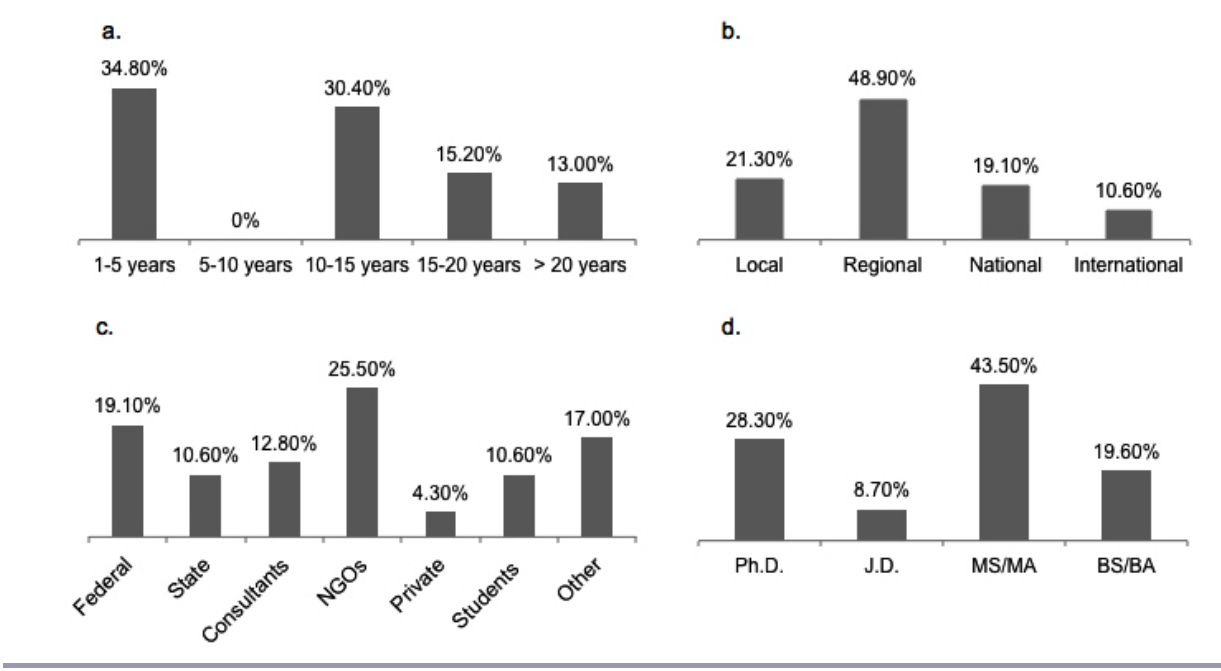
Fig. 1. Diversity of respondents in terms of years of experience (A), geographic affiliation (B), organizational affiliation (C), and education level (D).